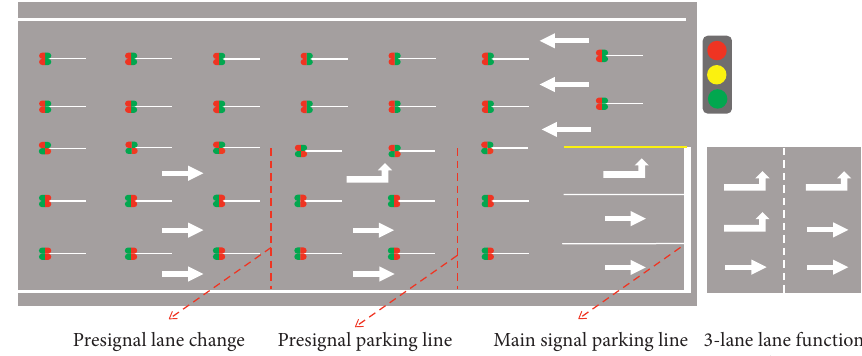
Figure 4: Illustration of the three-entrance-lane configuration.